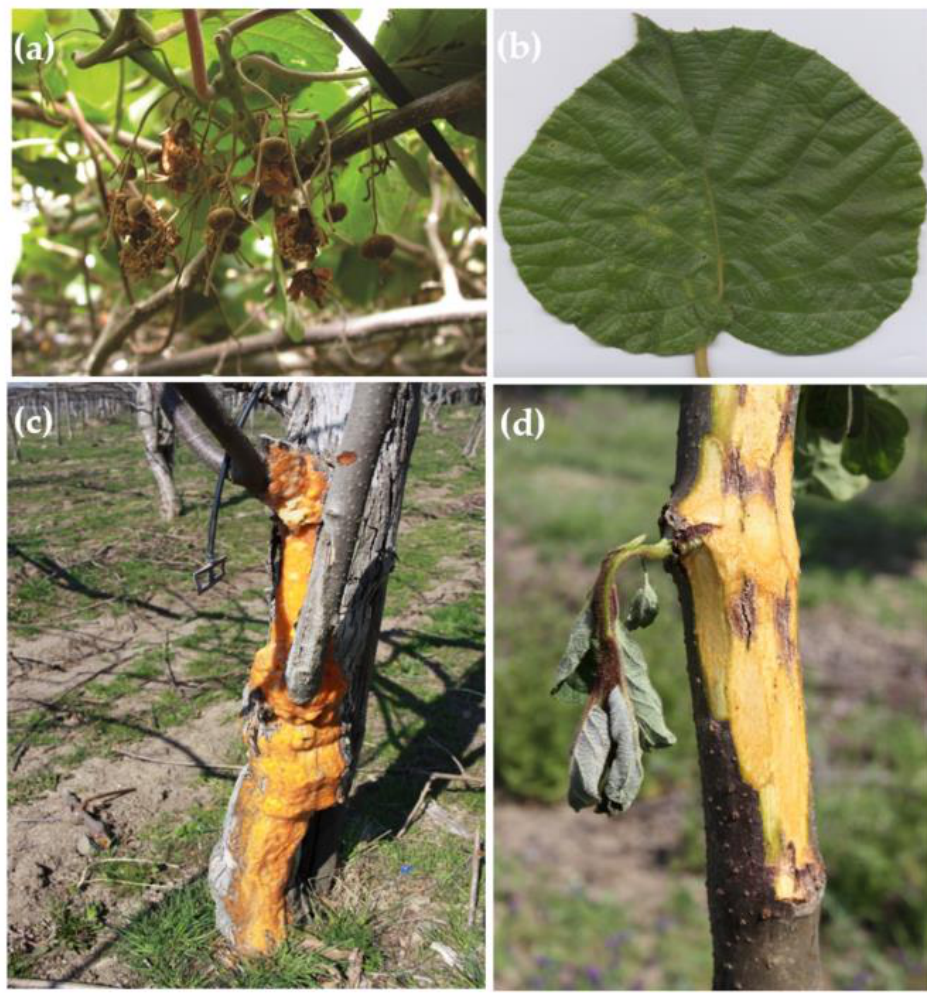
Figure 1. Pseudomonas syringae pv. actinidiae (Psa) symptoms on kiwifruit ( a ) buds and flowers ( b ) leaf ( c ) trunk (exudate) ( d ) new shoot. Photos’ credit: G.M. Balestra.